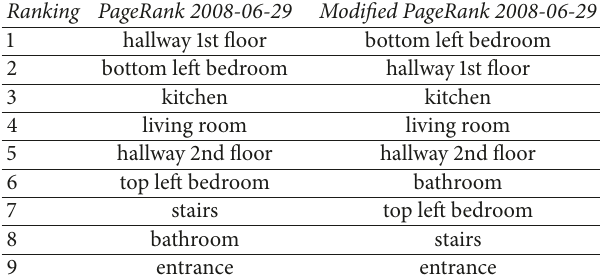
Table 4: Results of the first experiment. Ranking PageRank 2008-06-29